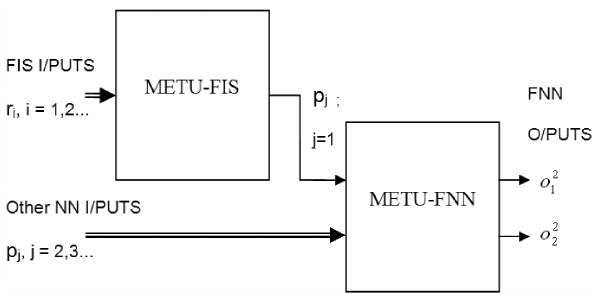
Fig. 2. Structure of the METU Fuzzy Inference